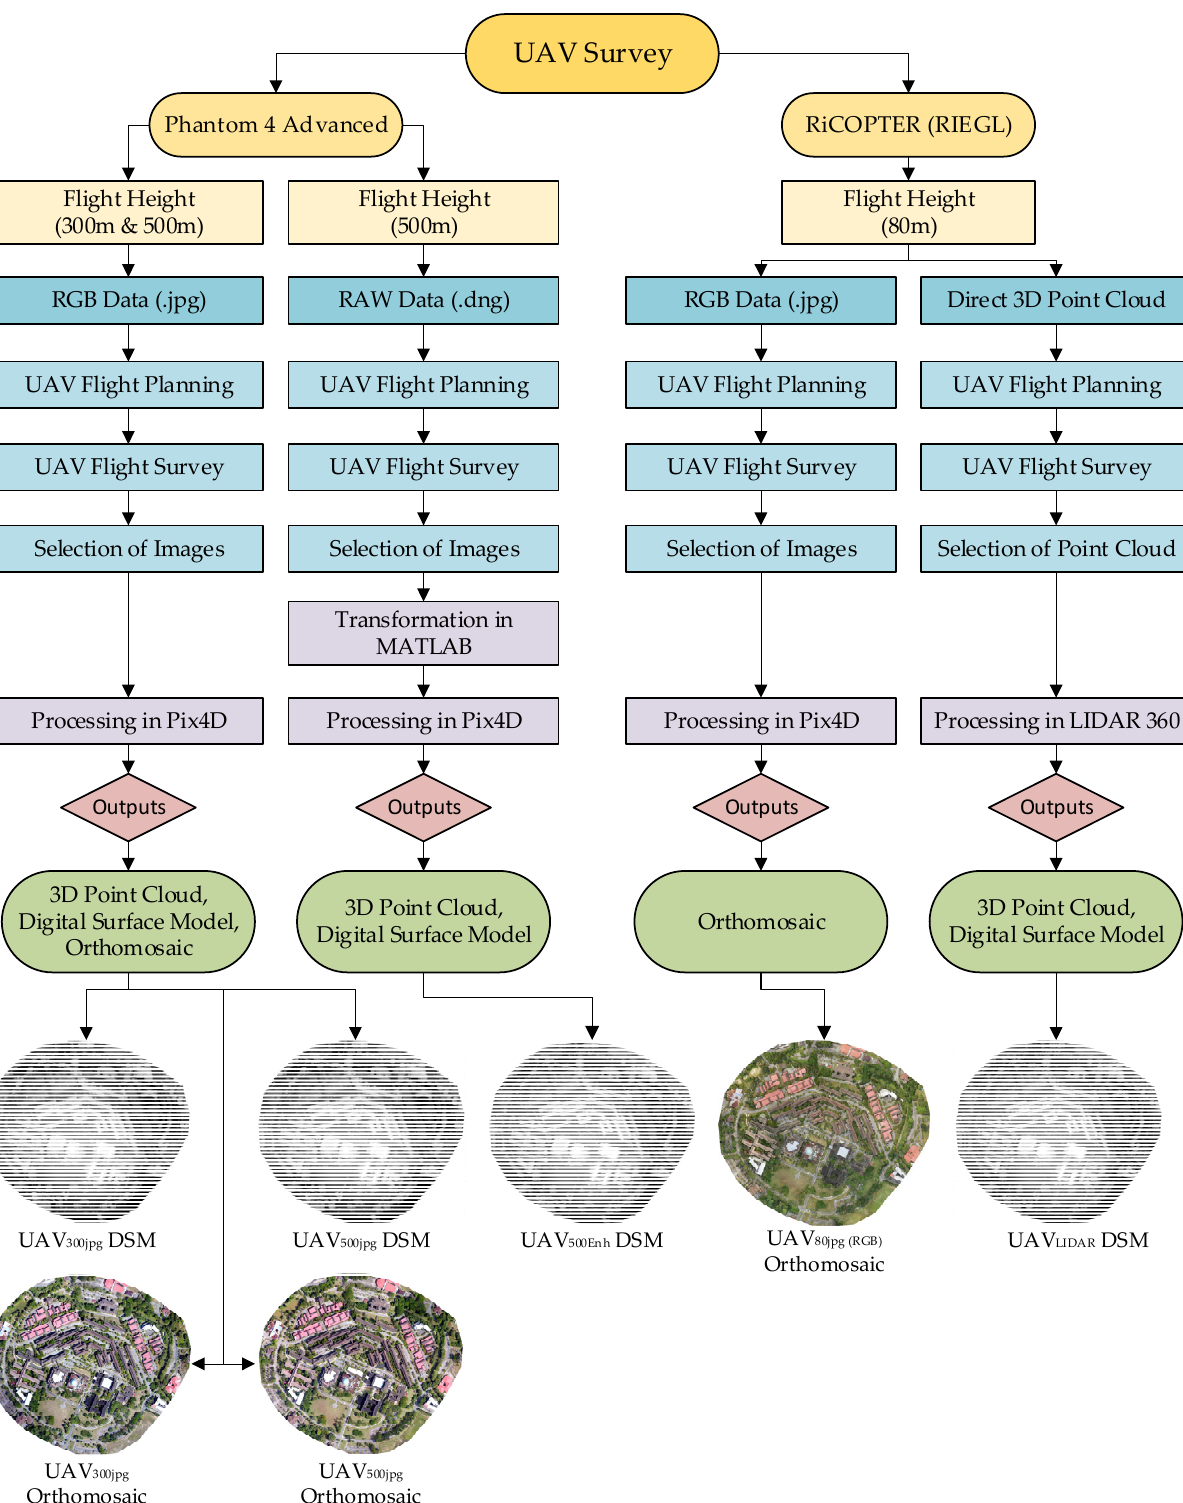
Figure 3. Methodology of the study.